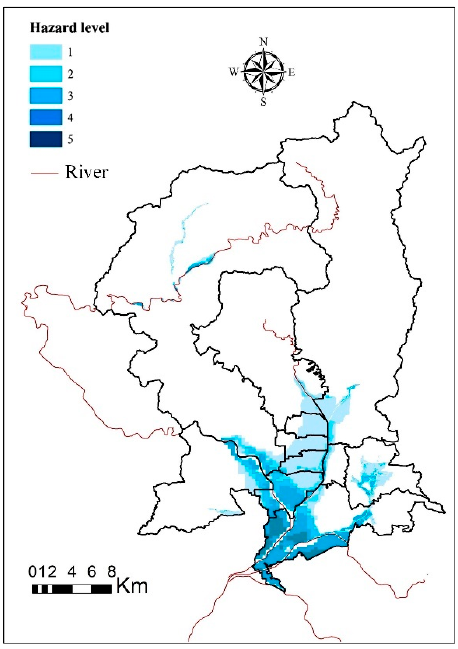
Figure 3. The hypothetical potential river flooding map used in this study.